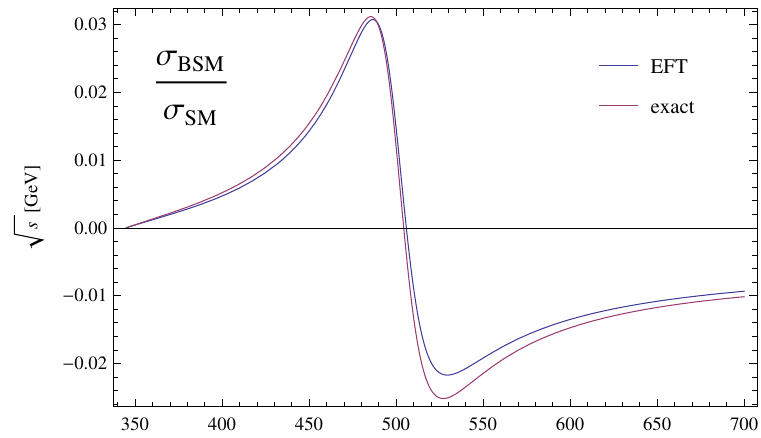
t (cid:22) t at LO, including the resonance signal and the !